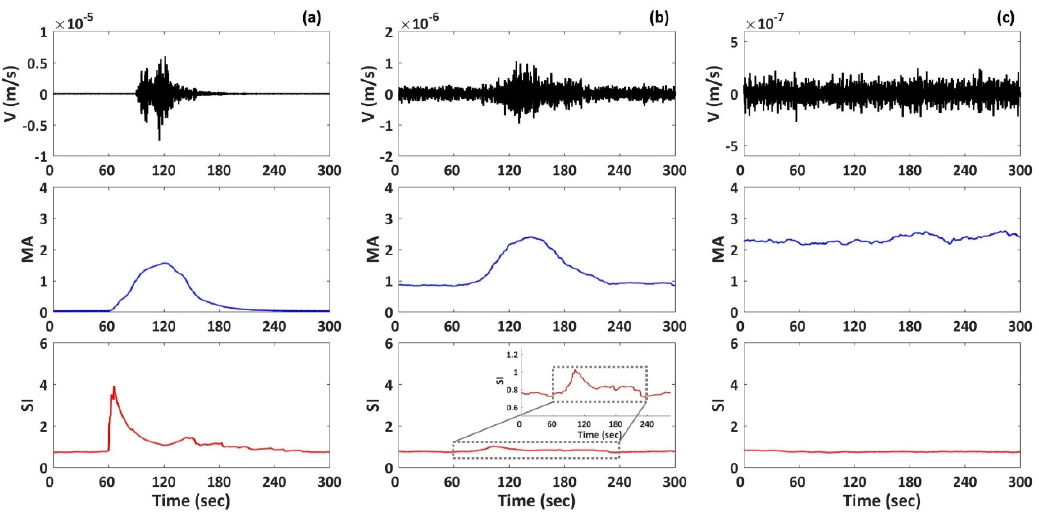
Figure 5. Moving average (MA) and scintillation index (SI) functions for the three commonly observed seismic events: ( a ) earthquakes; ( b ) landslides; ( c ) background noise.